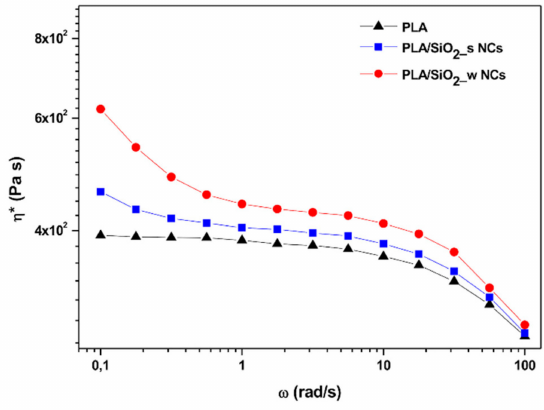
Figure 7. Complex viscosity of pure PLA and PLA / SiO 2_ s and PLA / SiO 2_ w